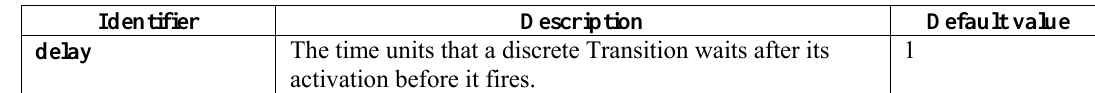
Table 4: Parameter only of a discrete Transition.